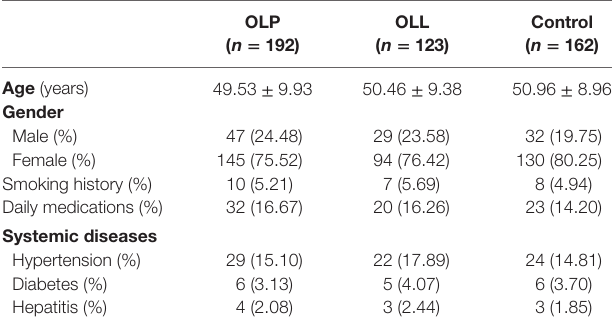
TaBle 1 | Demographics information of the oral lichen planus (OLP)/oral lichenoid lesion (OLL) and control groups.